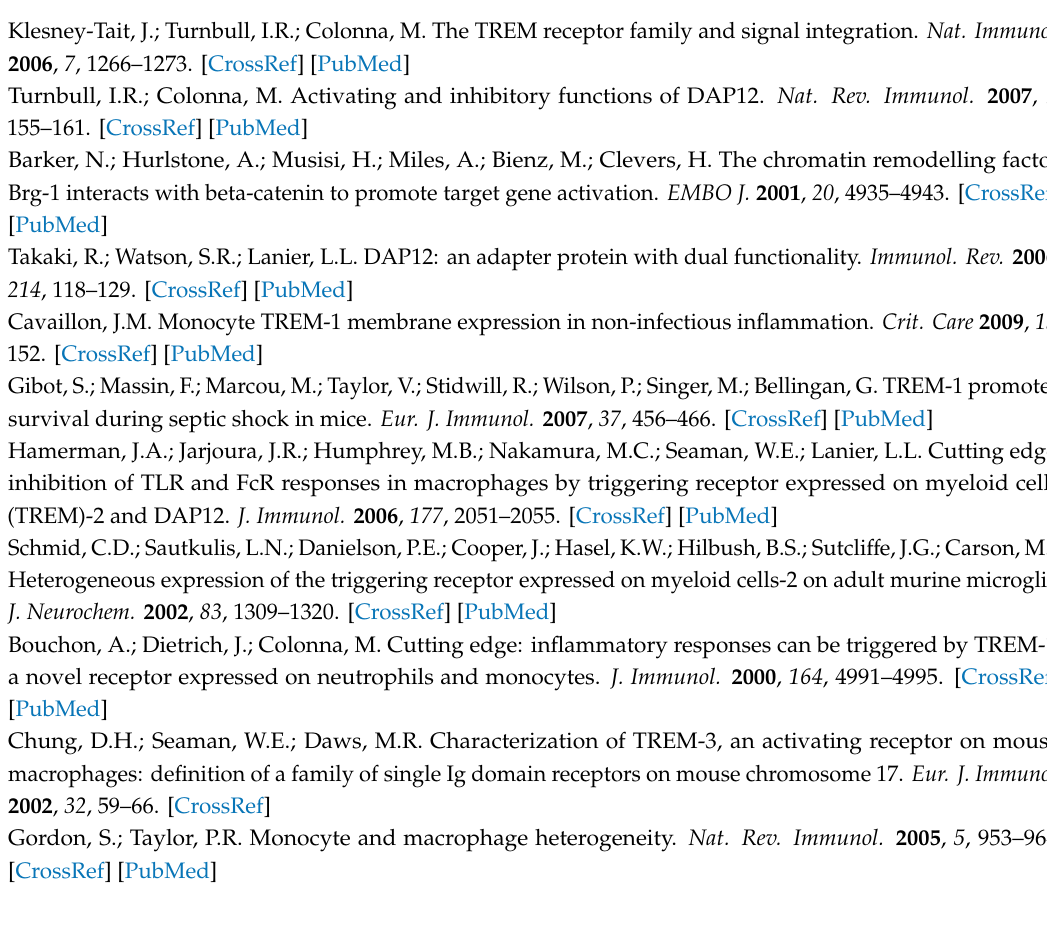
Figure S1: Infiltrated immune cell distribution and cytokine mRNA expression in tumors, Figure S2: Reduced protein expression of EpCAM in TREM2-TG mice compared with that in WT mice, Table S1: Real-time-PCR primer